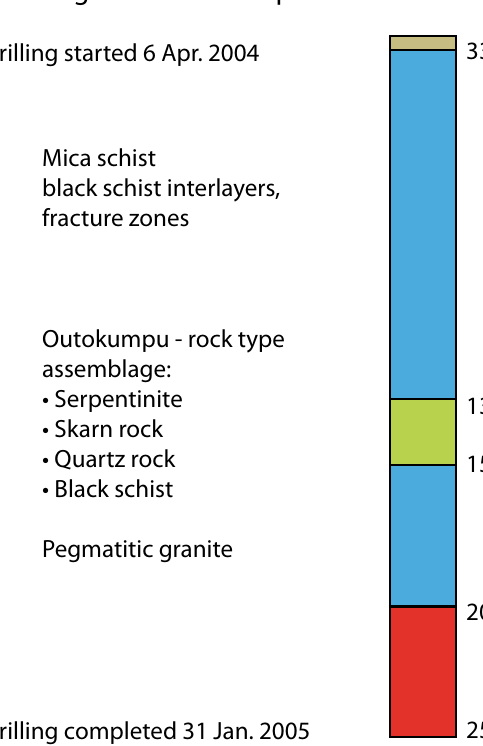
Lithologies of Outokumpu